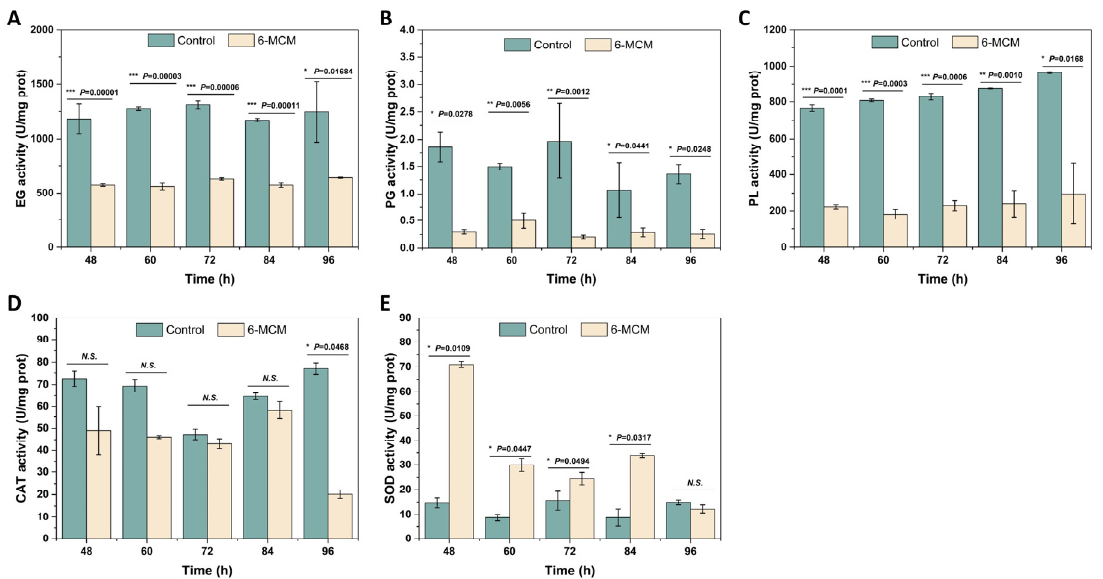
Figure 6. Effect of 6-methylcoumarin on enzyme activity of V. mali . ( A ) endo-1,4- β -D-glucanase (EG), ( B ) polygalacturonase (PG), ( C ) pectin lyase (PL), ( D ) catalase (CAT), ( E ) superoxide dismutase (SOD). V. mali was cultured in the PDB containing 10% Tween-80 (as a control) and 105 mg/L 6- methylcoumarin solution, respectively. The bars represent the standard error of the mean (n = 3), and the asterisks indicate that significant differences exist between 6-MCM treatment and control using an independent-sample t -test. 6-MCM, 6-methylcoumarin. N.S., no significance.